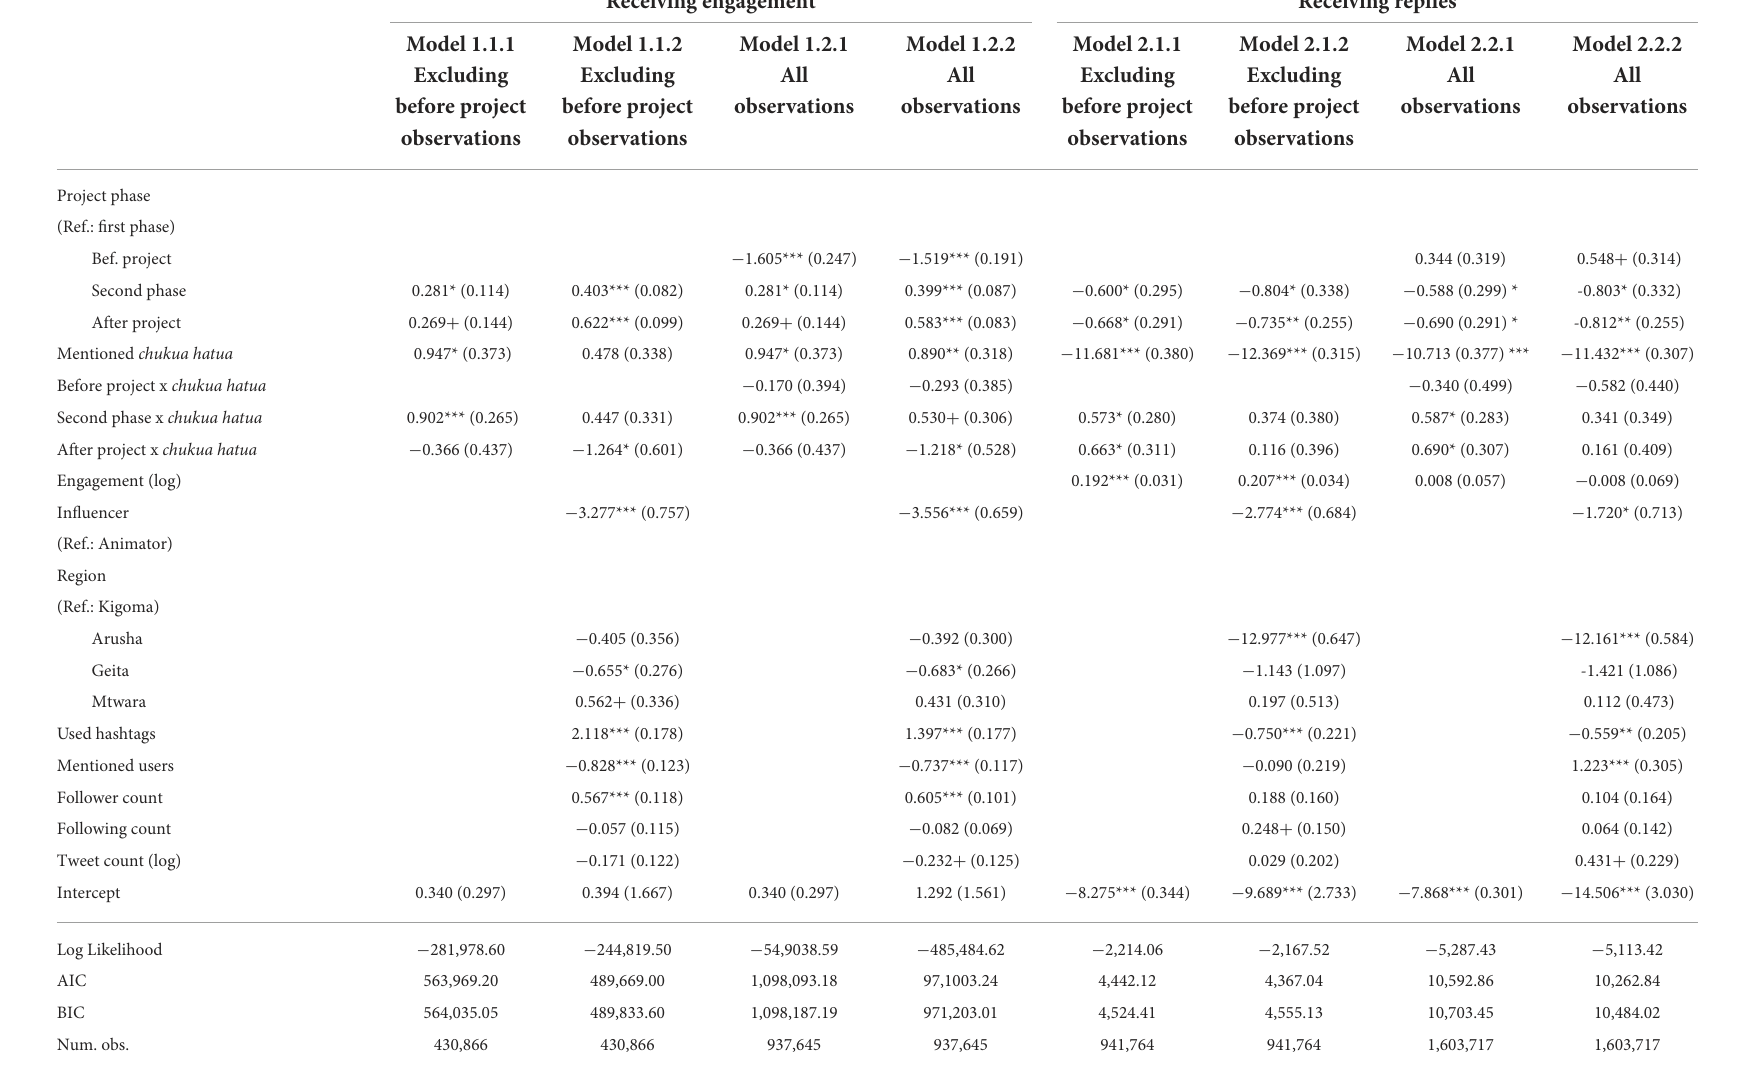
TABLE 5 Logit models on receiving engagement and